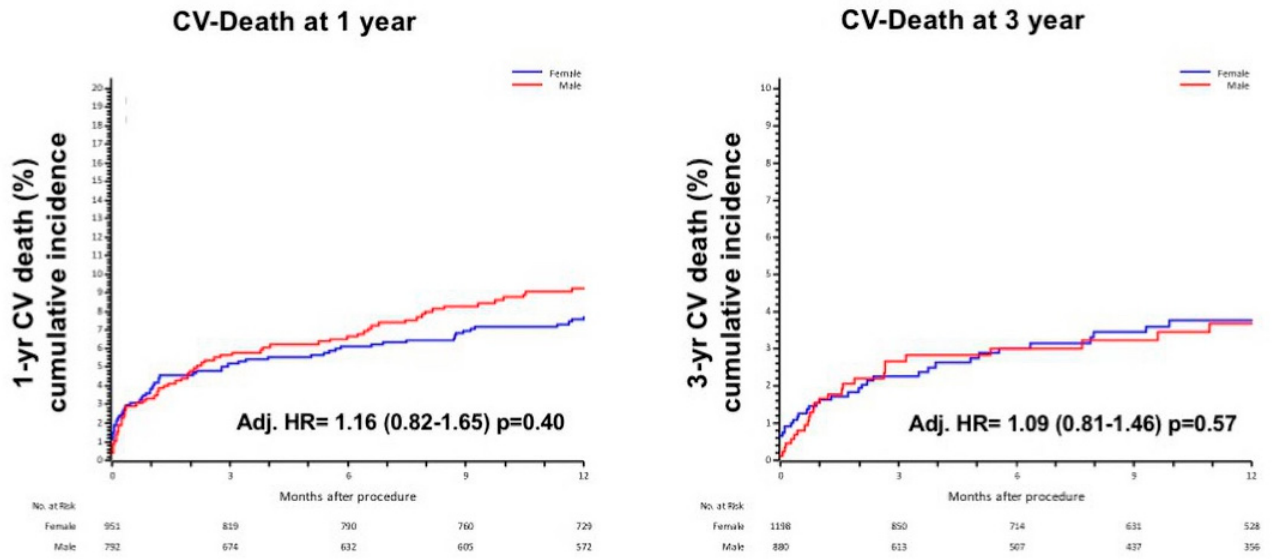
Figure 3. 1-year and 3 year CV death in male and female, adjusted for age, STS, previous MI and CAD.